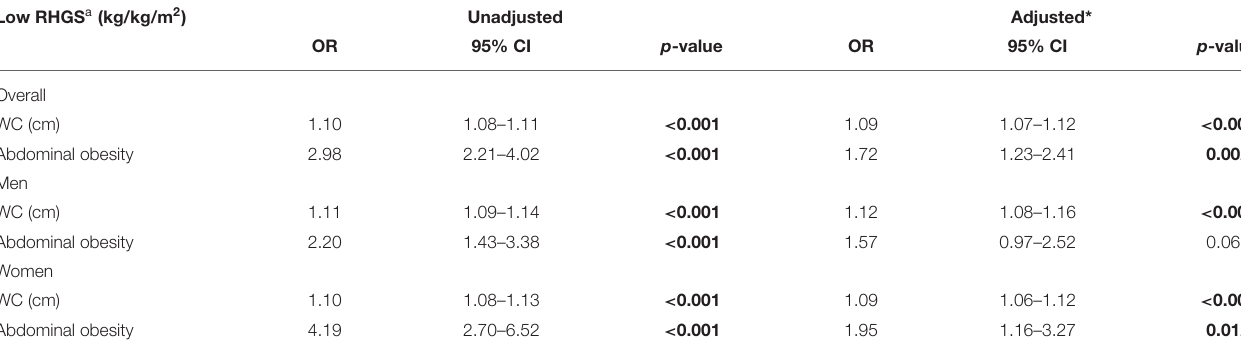
TABLE 4 | Associations between low relative handgrip strength and abdominal